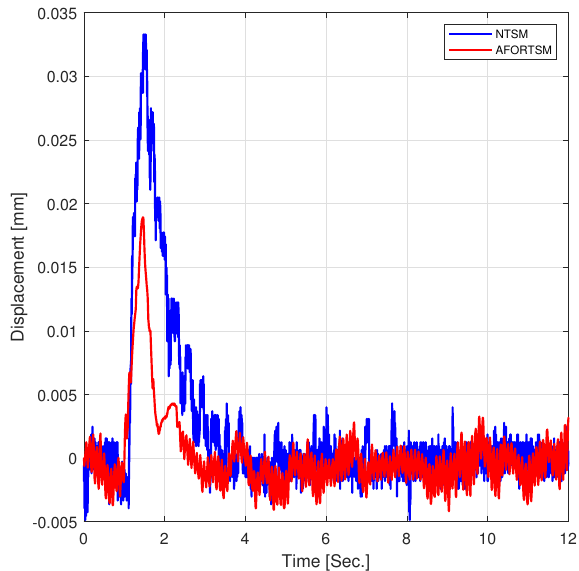
Figure 9. Test 8: Experimental results of shock disturbance rejection.